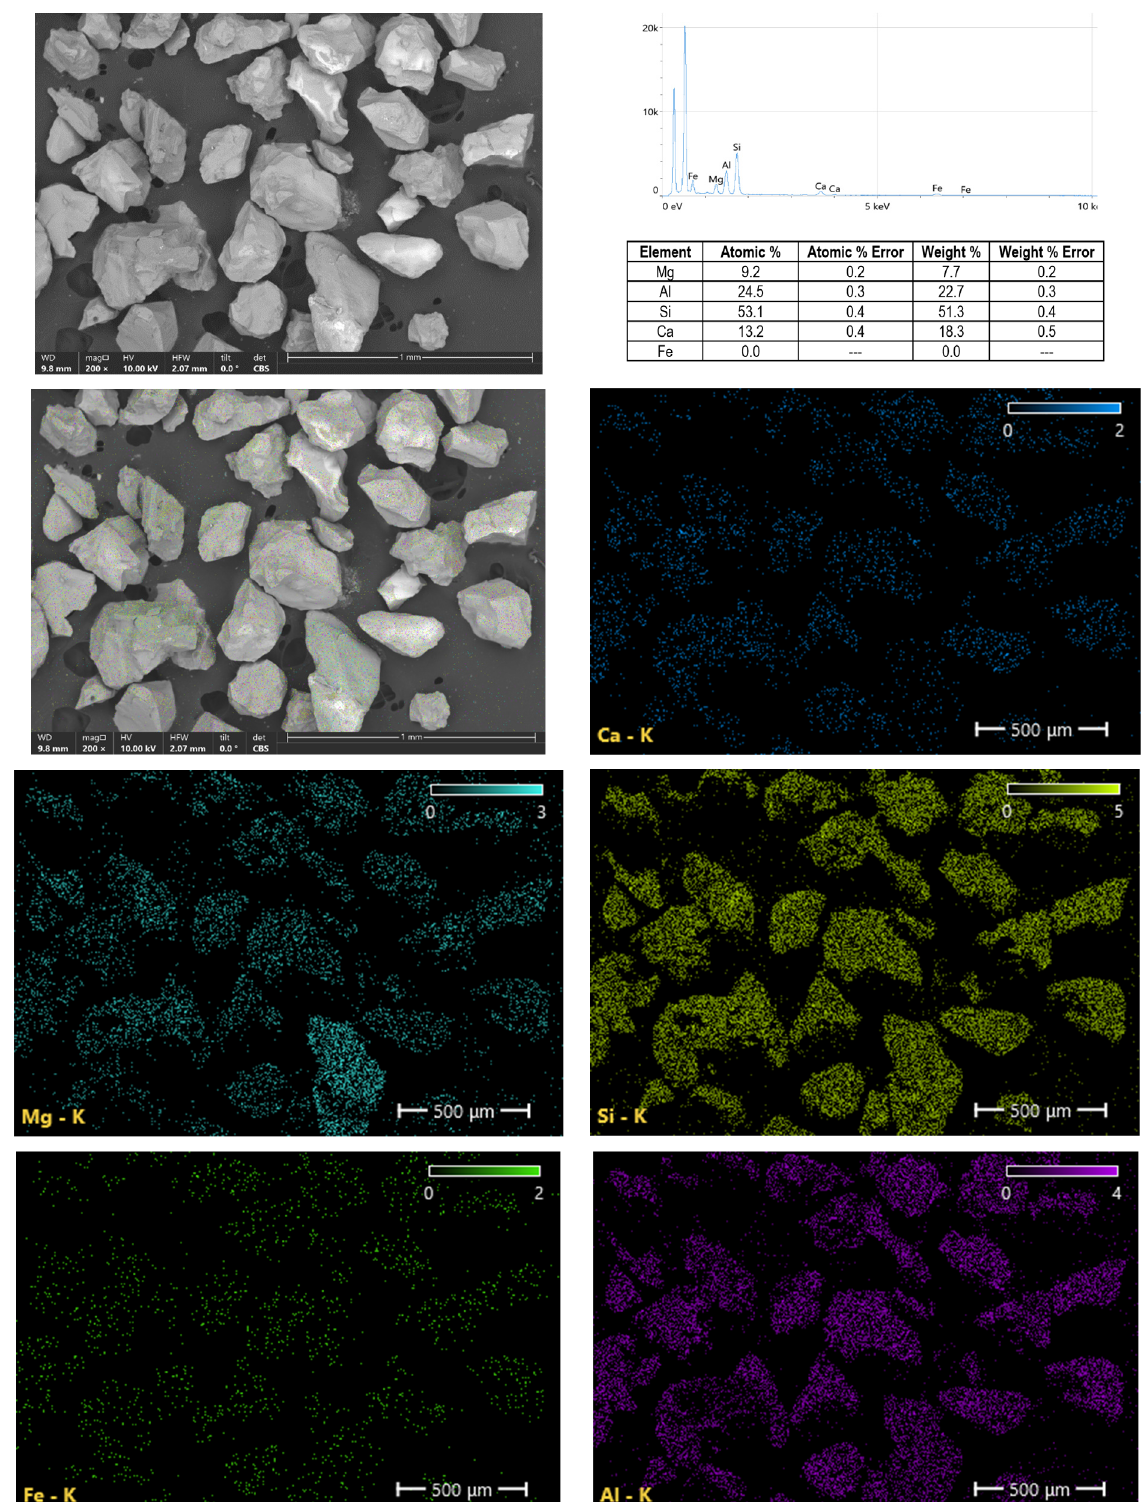
Figure 11. The XRF and EDX spectra of garnet.